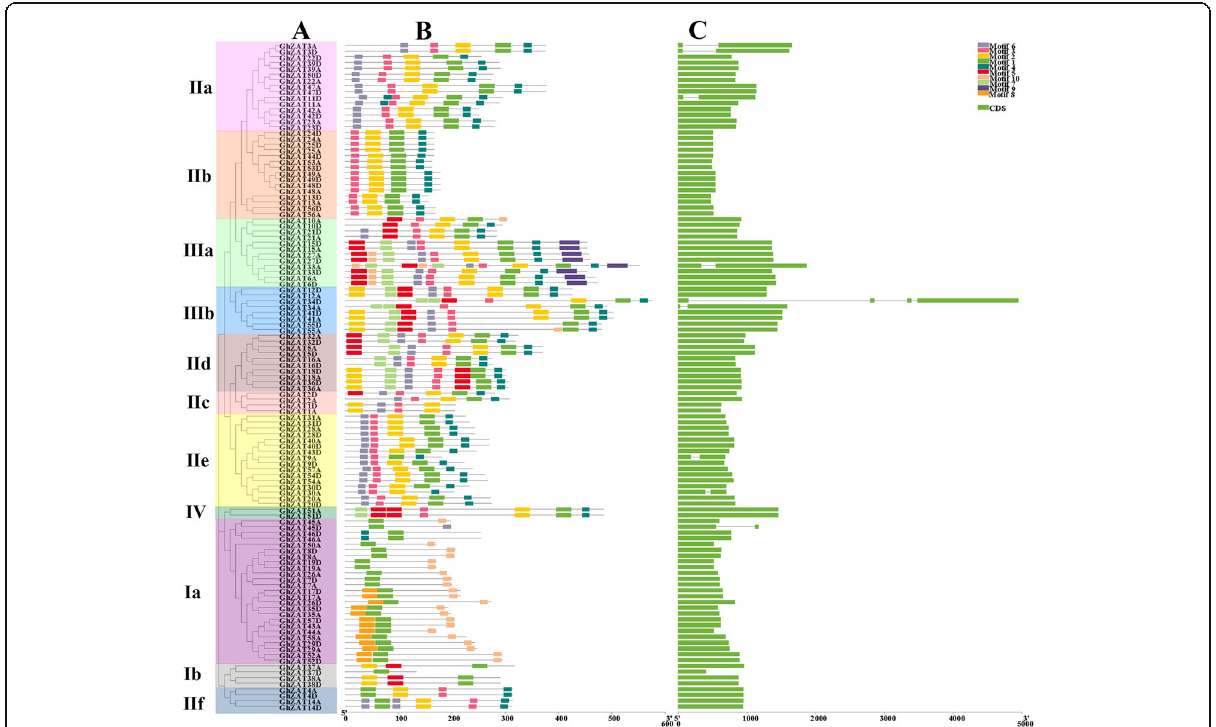
Fig. 5 Phylogenetic analysis, conserved motifs, and gene structures of GhZAT genes. A: Phylogenetic tree of GhZAT genes; B: Conserved motifs of GhZAT genes; C: Gene structures of GhZAT